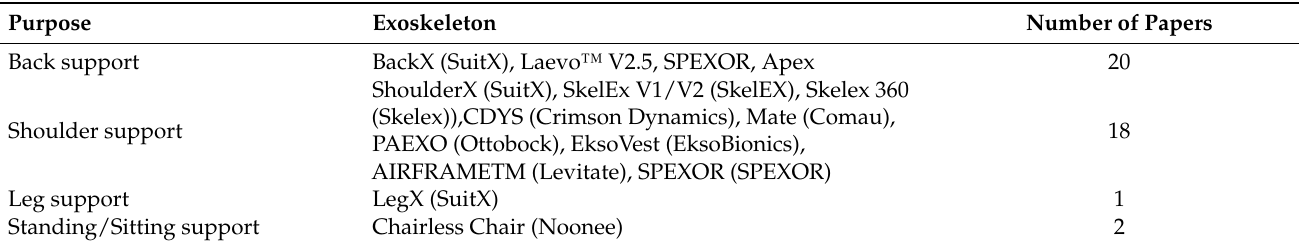
Table 4. Exoskeletons evaluated in the identified studies.